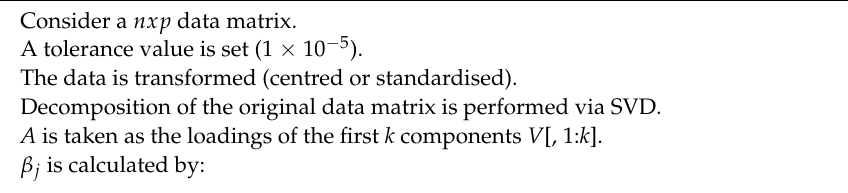
Algorithm 1 Sparse HJ biplot algorithm using elastic net